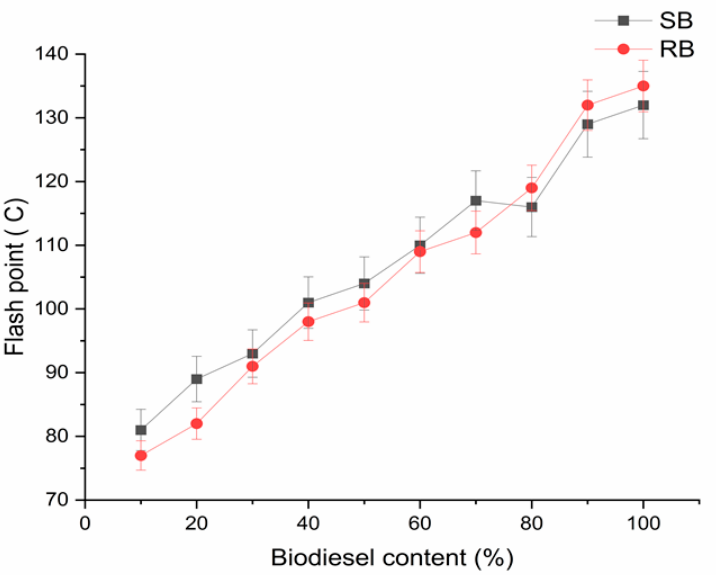
Figure 5. Relationship between flash point ( ◦ C) and biodiesel content in the biodiesel-diesel mixture. SB = sunflower biodiesel; RB = rapeseed biodiesel. Both were obtained using methanol at the optimal molar ratio, as described in the previous